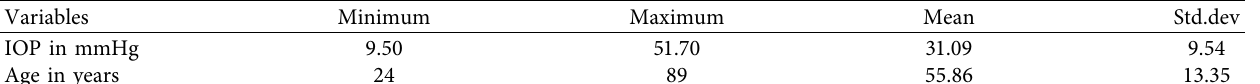
Table 2: Baseline characteristics of continuous variables of glaucoma patients ( n � 328).